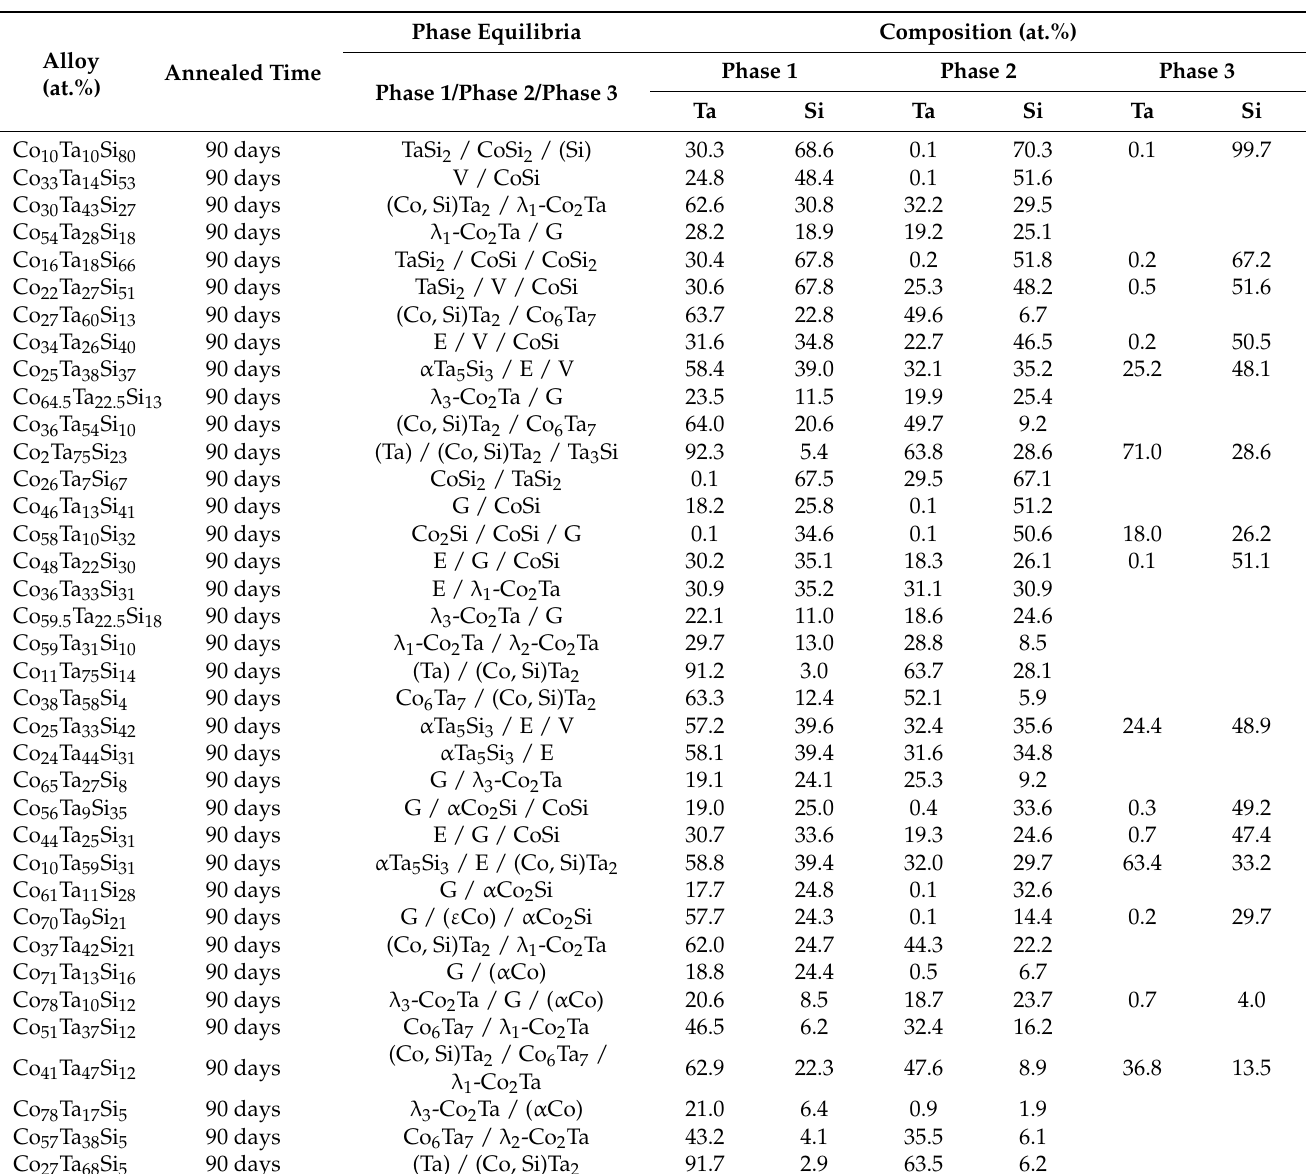
Figure 3. XRD patterns obtained of ( a ) Co 34 Ta 26 Si 40 alloy annealed at 1100 °C for 60 days and ( b ) Co 26 Ta 7 Si 67 alloy annealed at 1100 °C for 60 days. Table 2. Equilibrium compositions of the Co-Ta-Si ternary system at 900 ◦ C determined in the Zone 2 corresponds to the phase equilibria at the Ta-rich corner (Ta > 50 at.%). In present